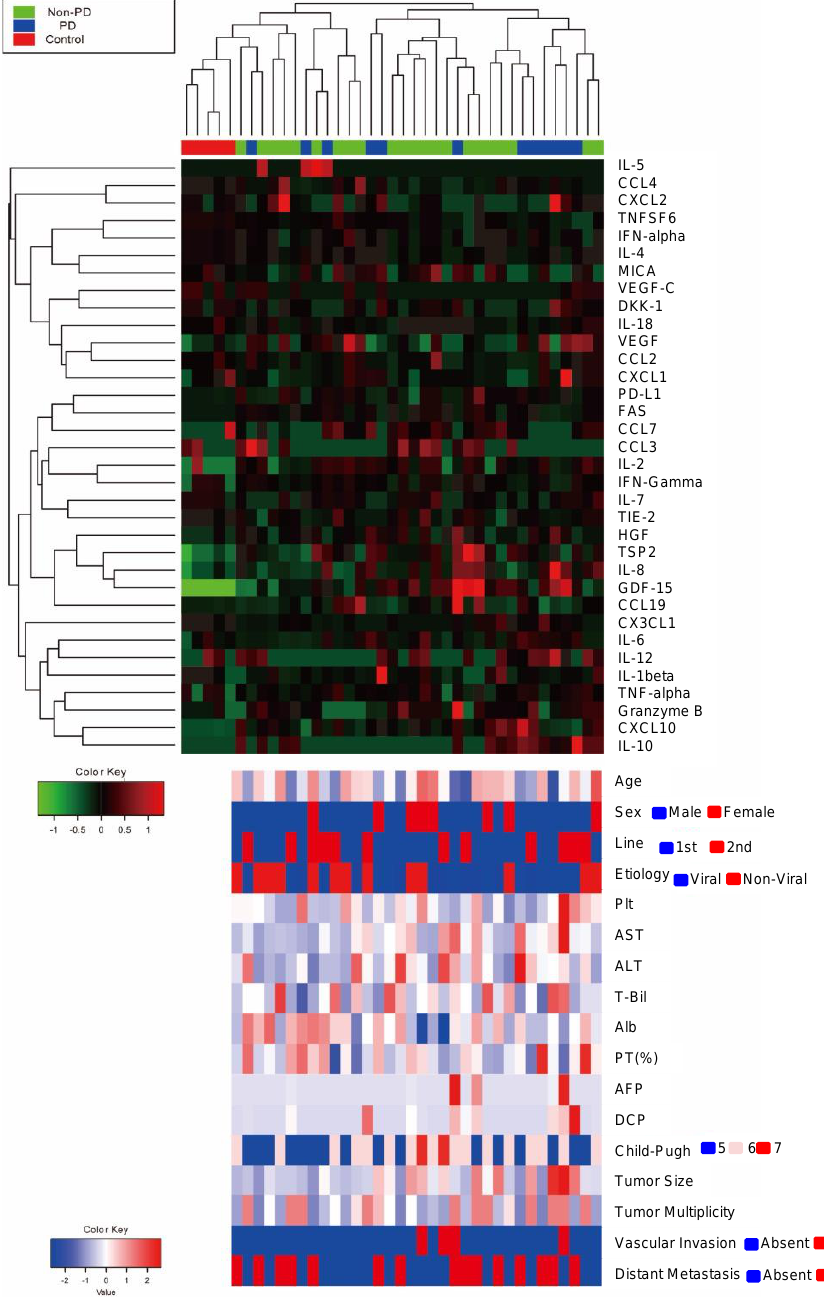
Figure 1. Heatmap of 34 plasma proteins quantified by a multiplex bead-based immunoassay using the baseline plasma of 34 HCC patients treated with Atezo/Bev therapy and 5 healthy controls. The upper heatmap shows each protein level, and the bottom heatmap shows patient backgrounds. IL-5, interleukin-5; CCL4, CC motif chemokine 4; CXCL2, C-X-C motif ligand 2; TNFSF6, tumor necrosis factor superfamily 6; IFN-alpha, interferon-alpha; IL-4, interleukin-4; MICA, MHC class I polypeptide-related sequence A; VEGF-C, vascular endothelial growth factor-C; DKK-1, dickkopf related protein-1; IL-18, interleukin-18; VEGF, vascular endothelial growth factor; CCL2, CC motif chemokine 2; CXCL1: C-X-C motif ligand 1; PD-L1, programmed death-ligand 1; CCL7: CC motif chemokine 7; CCL3, CC motif chemokine 3; IL-2: interleukin-2; IFN-Gamma: interferon-gamma; IL- 7, interleukin-7; HGF, hepatocyte growth factor; TSP2, thrombospondin 2; IL-8, interleukin-8; GDF-